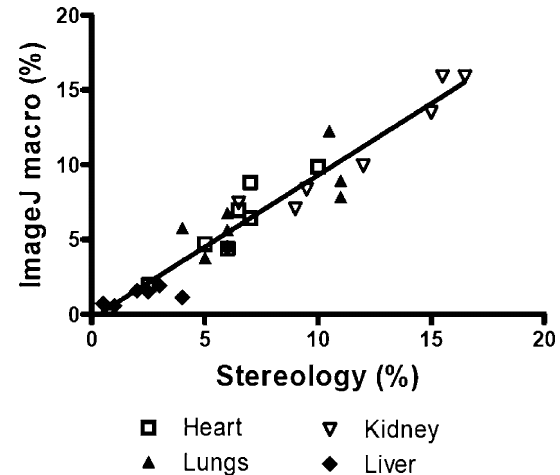
Fig. 7. The ImageJ macro was able to detect fibrosis in paraf- fin-embedded sections of human tissue of heart, lung, kidney and liver in the same way as in cardiac tissue of rat and a similar corre- lation was found with stereology ( r 2 = 0 .